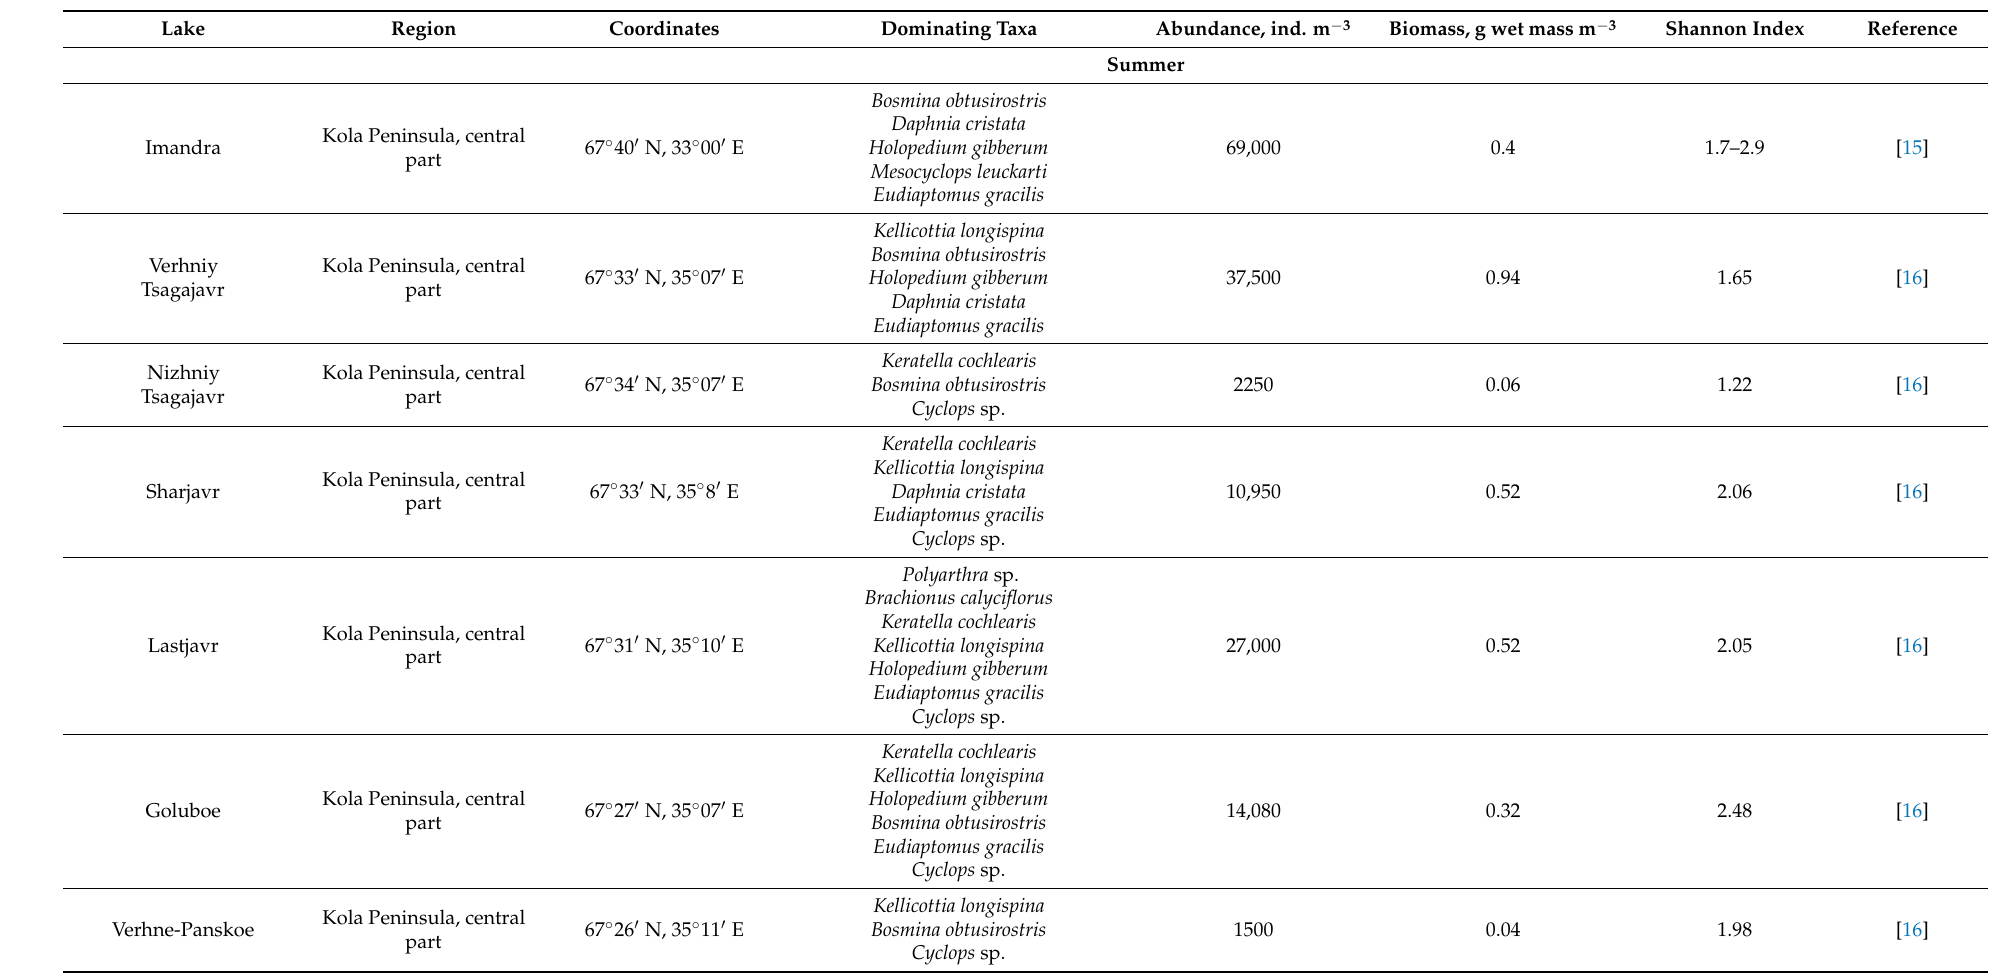
Table 4. The zooplankton of oligotrophic lakes in the Russian sub-arctic